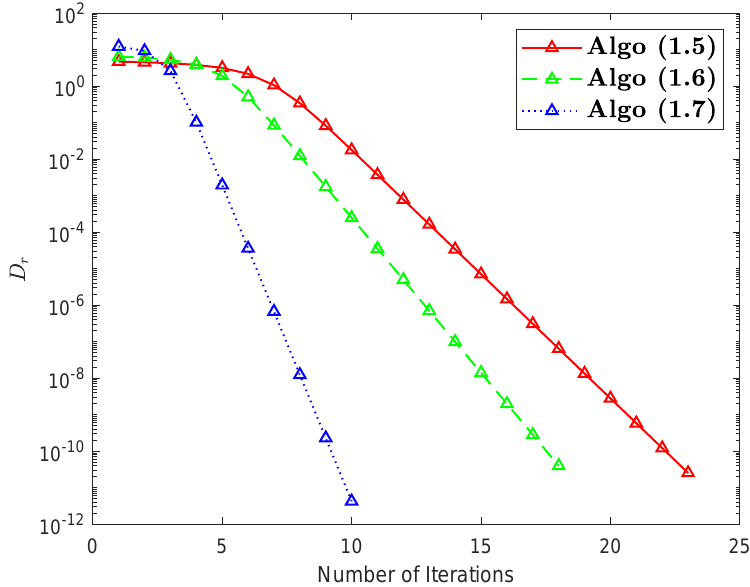
Figure 3. A graphical comparison of Algorithms (5)–(7), where z 1 =